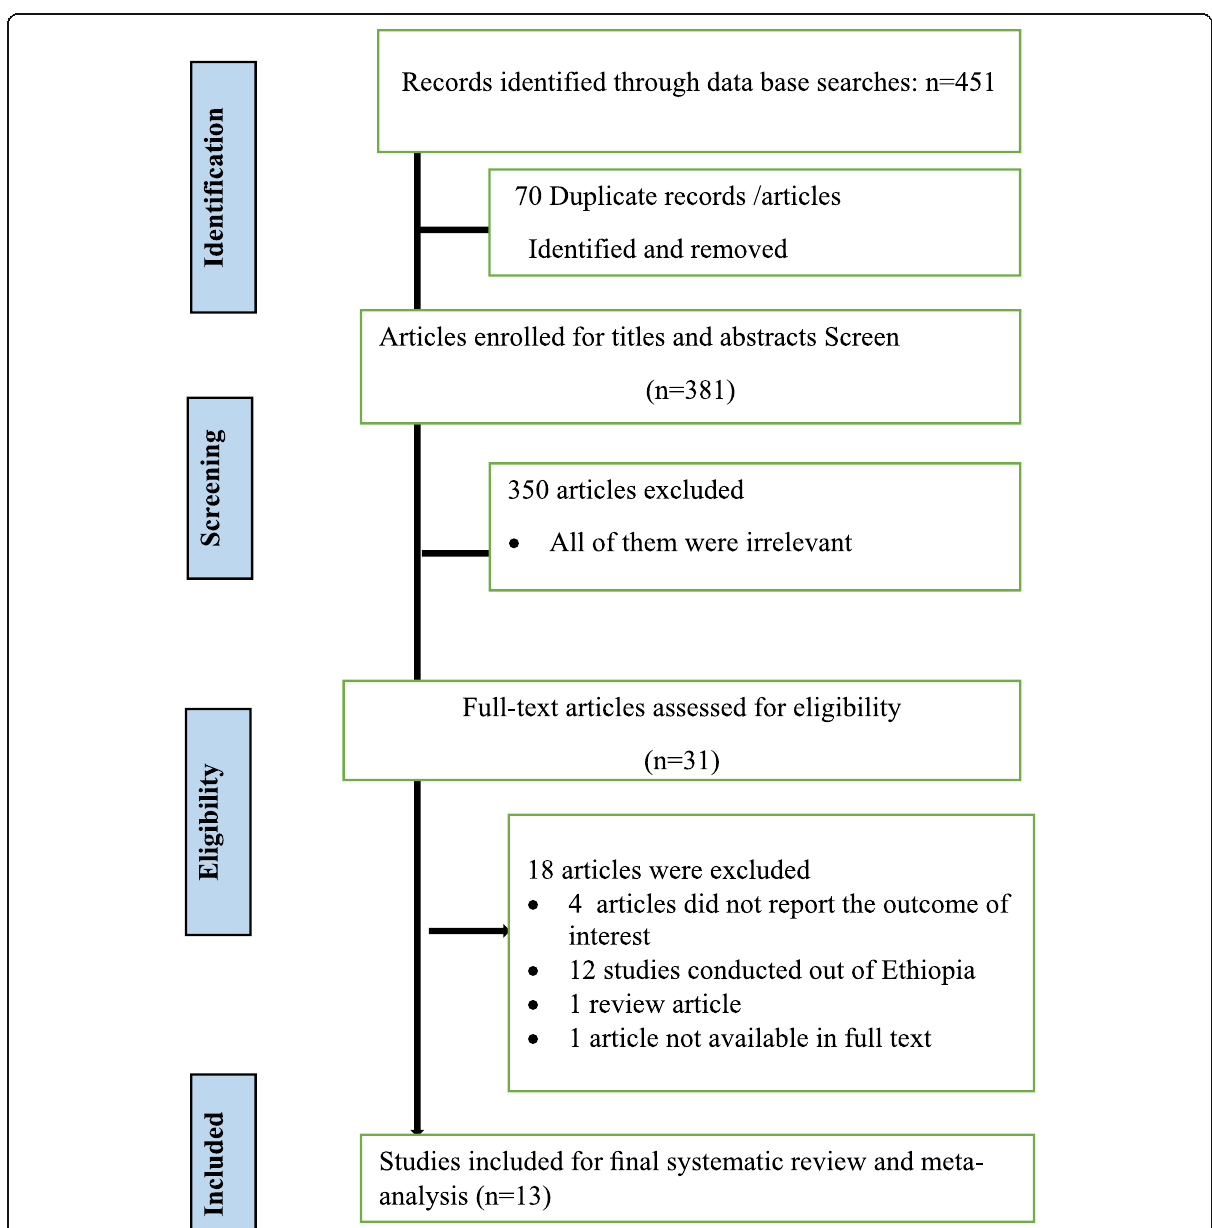
Fig. 1 PIRSMA flowchart diagram of selected studies for meta-analysis,